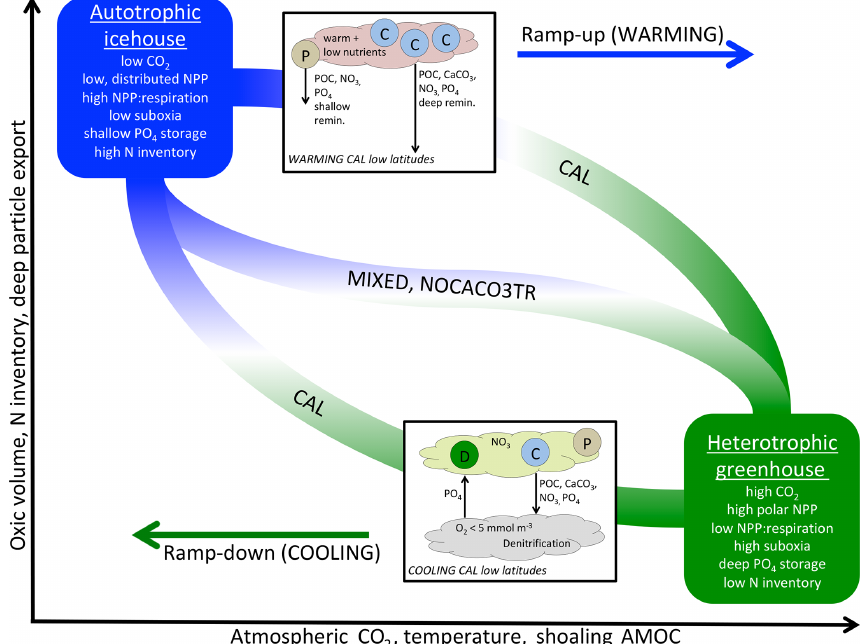
Figure 6. A qualitative depiction of biogeochemical controls of calcifiers in WARMING and COOLING simulations. The biogeochemical transition between the two productivity regimes ( y axis) occurs along a pathway of changes to temperature and ocean circulation, which are driven exclusively by forcing of atmospheric CO 2 in our simulations ( x axis). Calcifiers control the pace of the biogeochemical transition through two mechanisms: PIC ballasting of POC and ecological competition. Application of explicit calcifiers and a PIC ballast model slows the pace of transition in both directions and reduces the magnitude of the total equilibrated change in suboxic volume, N inventory, and particle export. Application of explicit calcifiers, without ballasting, enhances the pace of transition along the pathway in both directions. Inset into the figure are diagrams depicting the low-latitude nutrient exchange between calcifiers (C) and mixed phytoplankton (P) in WARMING, and diazotrophs (D) and calcifiers (C) in the CAL model in COOLING. Calcifiers export carbon and nutrients with both ballasted and non-ballasted particles. In WARMING, calcifiers benefit from warming and stratification and efficiently export particles for deep-ocean remineralization and dissolution. This inhibits the recycling of nutrients in the near-surface area to form regenerated production by other phytoplankton (P), slowing the transition into greenhouse climate conditions. In COOLING, low-latitude denitrification reduces the nitrate content in upwelled water, which promotes the growth of diazotrophs. The fixed nitrate is used by the calcifiers, and thus both phytoplankton types benefit each other. Mixed phytoplankton (P) also benefit from nitrate fertilization, though the effect is